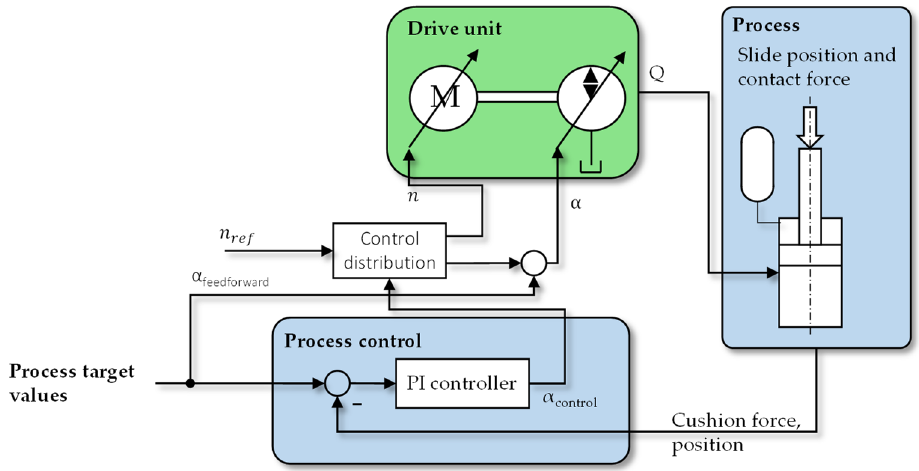
Figure 10. Schematic representation of the control variable distribution for maximal dynamics.